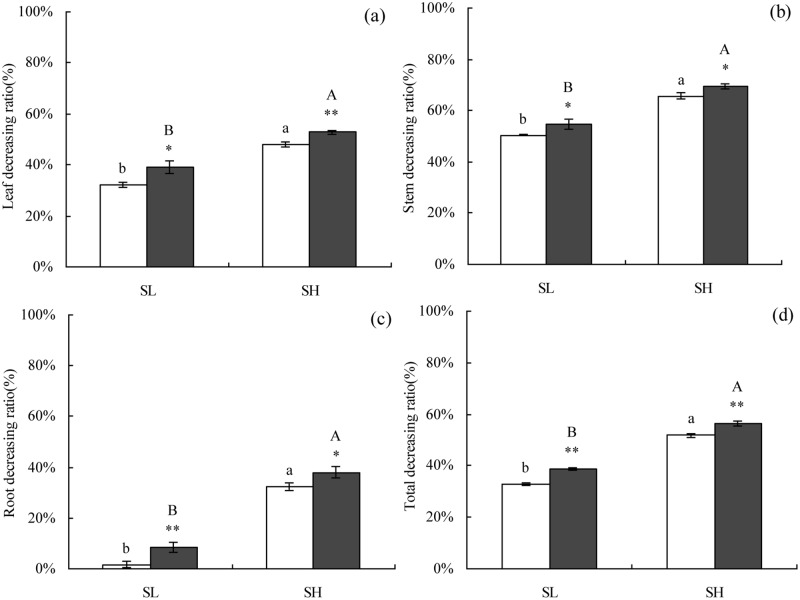
Effect of NaCl stress on growth decreasing ratio of cotton.Symbols indicate L24 cultivar (white bar) and X45 cultivar (black bar). Vertical bars represent ± standard error (n = 3). Asterisks indicate a significant difference between L24 and X45 (*P<0.05; **P<0.01). Bars labeled with the different lowercase letters on open square bars or uppercase letters on closed square bars are significantly different (P<0.05). (a), (b), (c), and (d) indicate the growth inhibition rate in the roots, stems, leaves, and total, respectively.